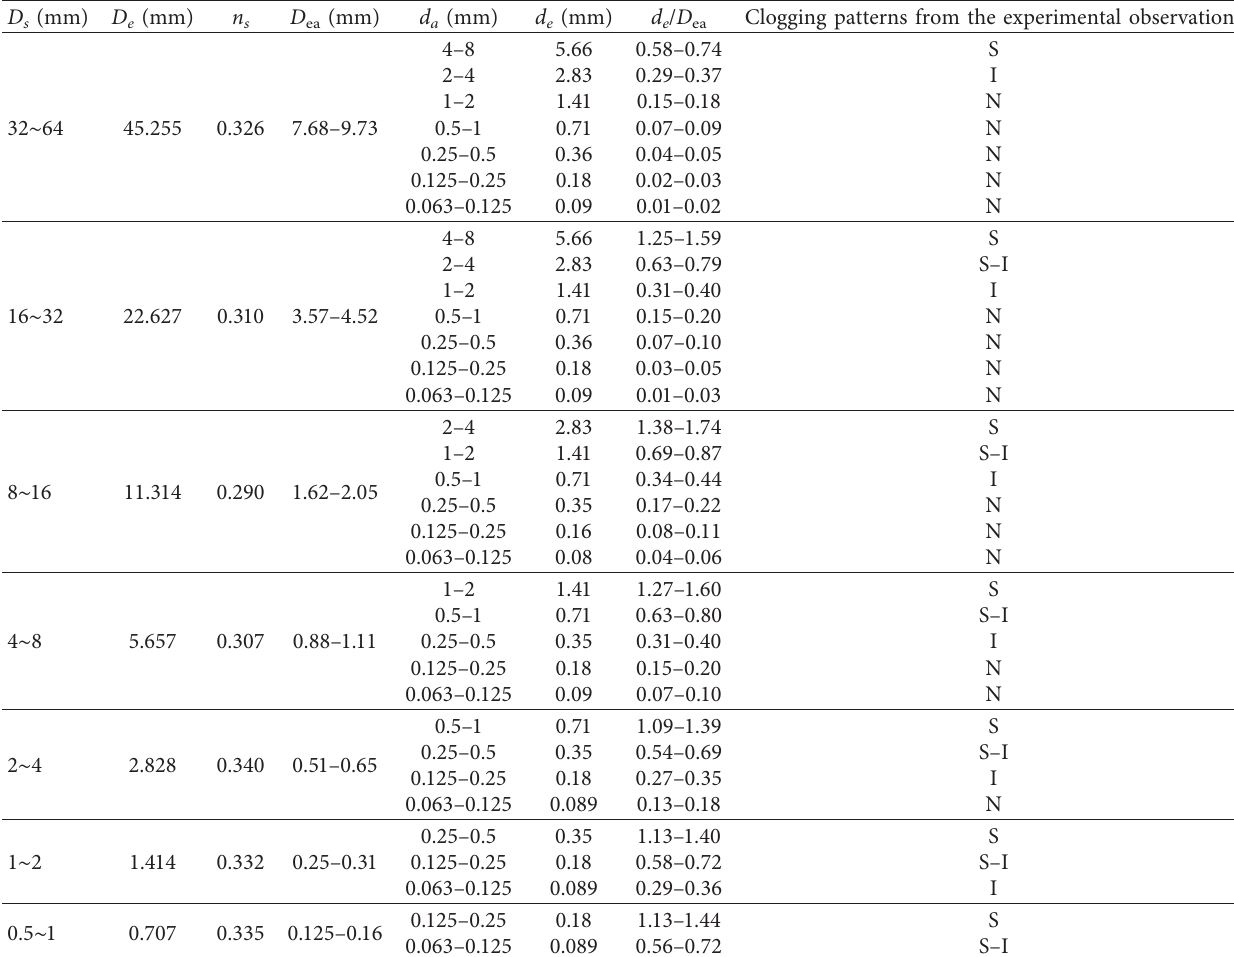
Table 4: Calculation